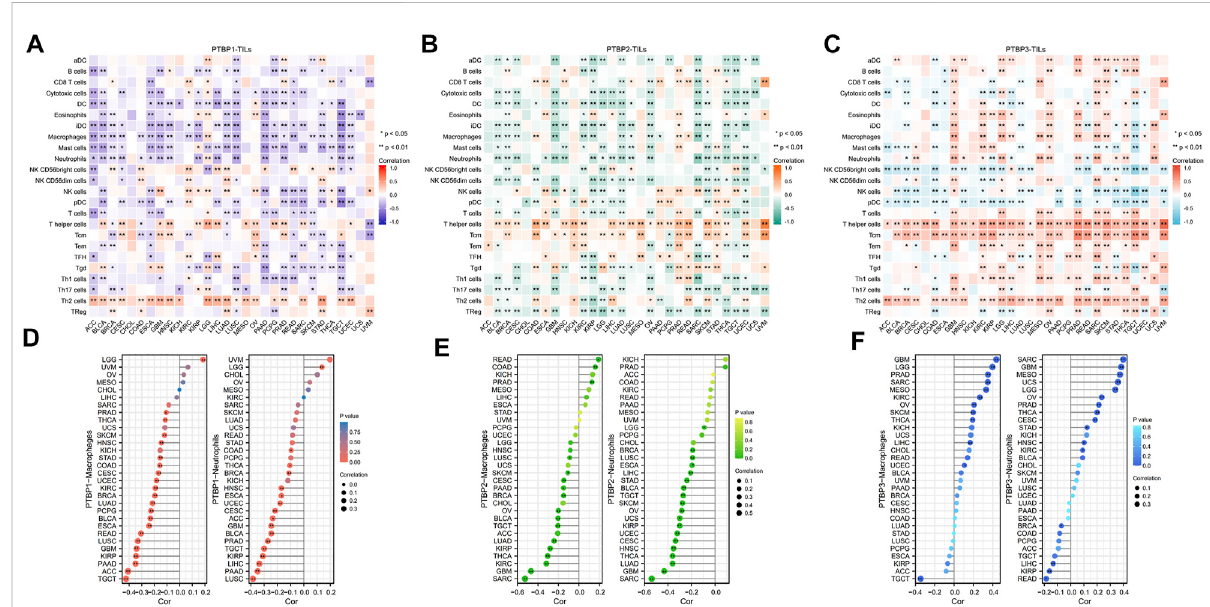
FIGURE 6 Correlation of PTBP expression with tumor-in fi ltrating lymphocytes in the tumor microenvironment in pan-cancer. (A – C) Heatmap of the correlation of PTBP expression with 24 TILs in pan-cancer. (D – F) The correlation of PTBP expression with macrophages and neutrophils in various tumors is shown in detail in lollipop plots (* p < 0.05; ** p <